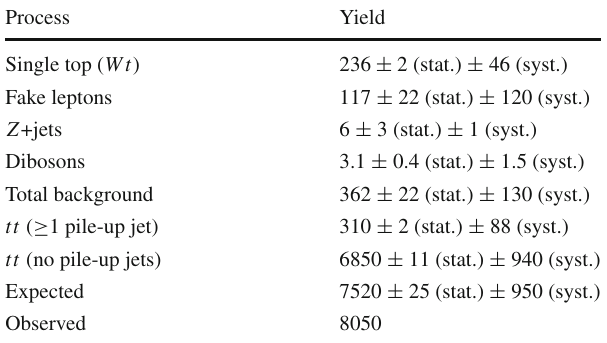
Table 1 Yields of data and MC events fulfilling the selection criteria